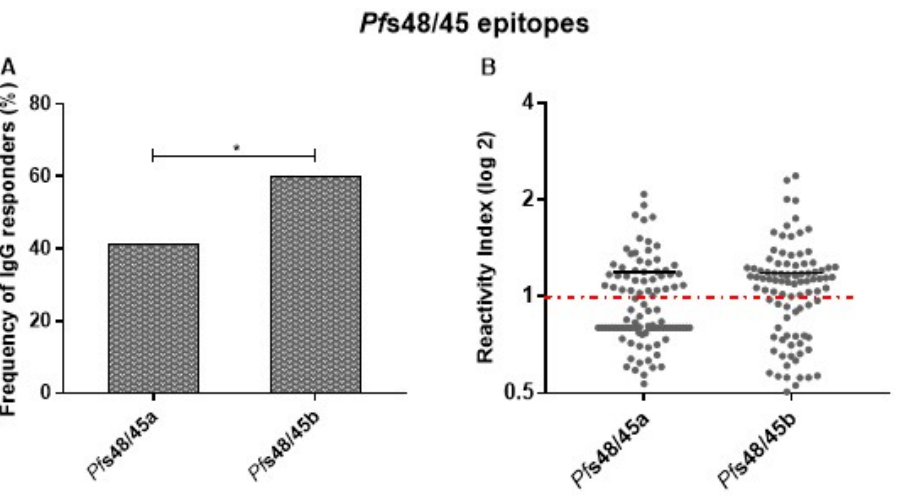
Figure 5. Frequency and levels of IgG antibodies against predicted Pf s48/45 291–428 epitopes. ( A ) Fre- quencies of IgG responders to Pf s48/45 291–428 epitopes. * p = 0.0097. ( B ) Levels of IgG antibodies to Pf s48/45 291–428 epitopes. Reactivity indices are individual values. The dashed red line represents the positivity limit. Lines represent the median.